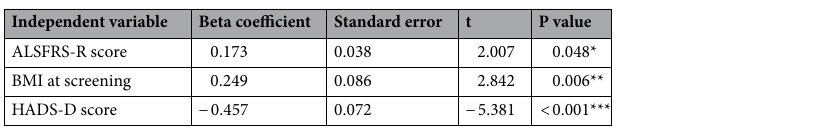
Table 5. Multivariable linear regression model of CNAQ-C. ALSFRS-R ALS Functional Rating Scale-Revised, BMI body mass index, HADS-D Hospital Anxiety and Depression Scale-Depression. *p < 0.05; **p < 0.01; ***p <